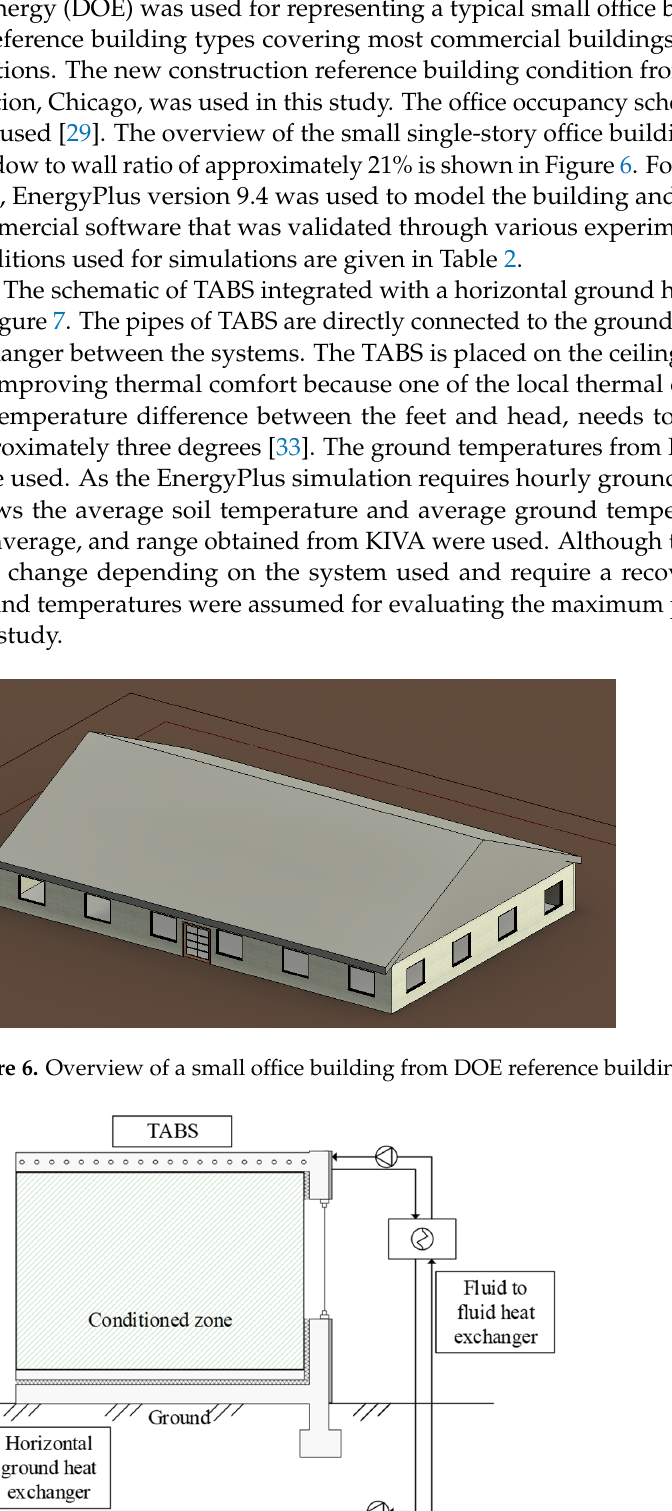
Figure 7. Schematic of TABS integrated with horizontal ground heat exchanger. Table 2. Boundary conditions used in the simulations.